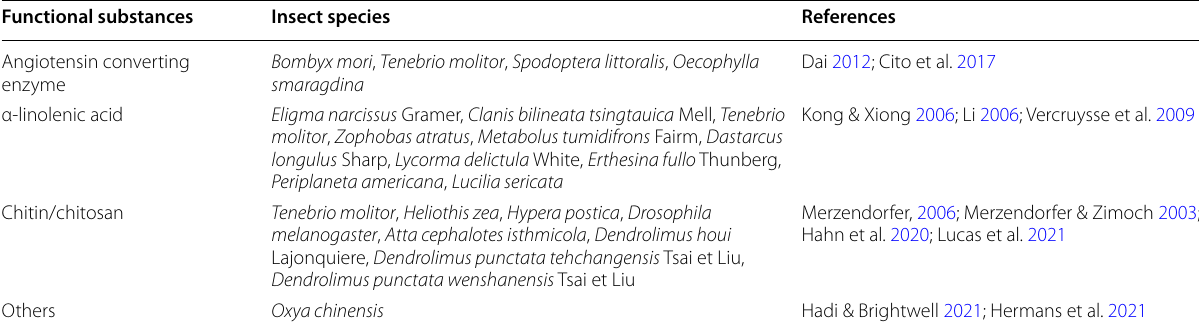
Table 4 The functional substances of reducing blood pressure in edible insects